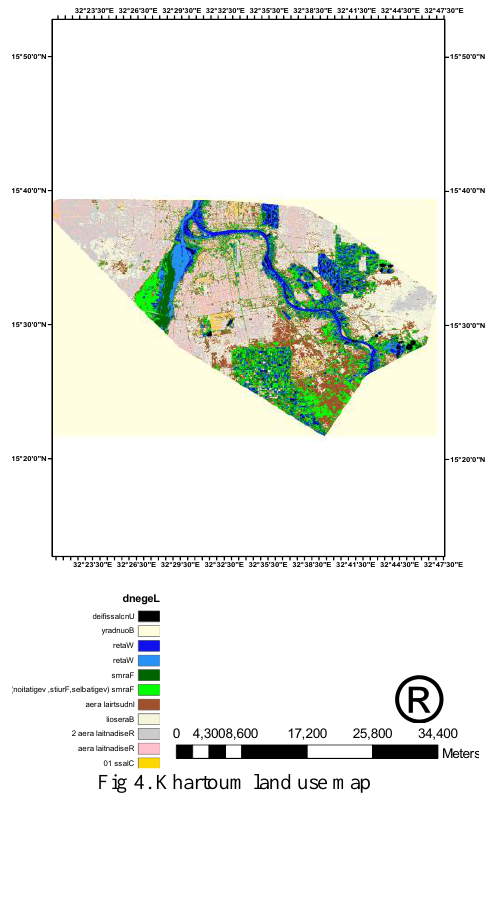
Fig 4. Khartoum land use map